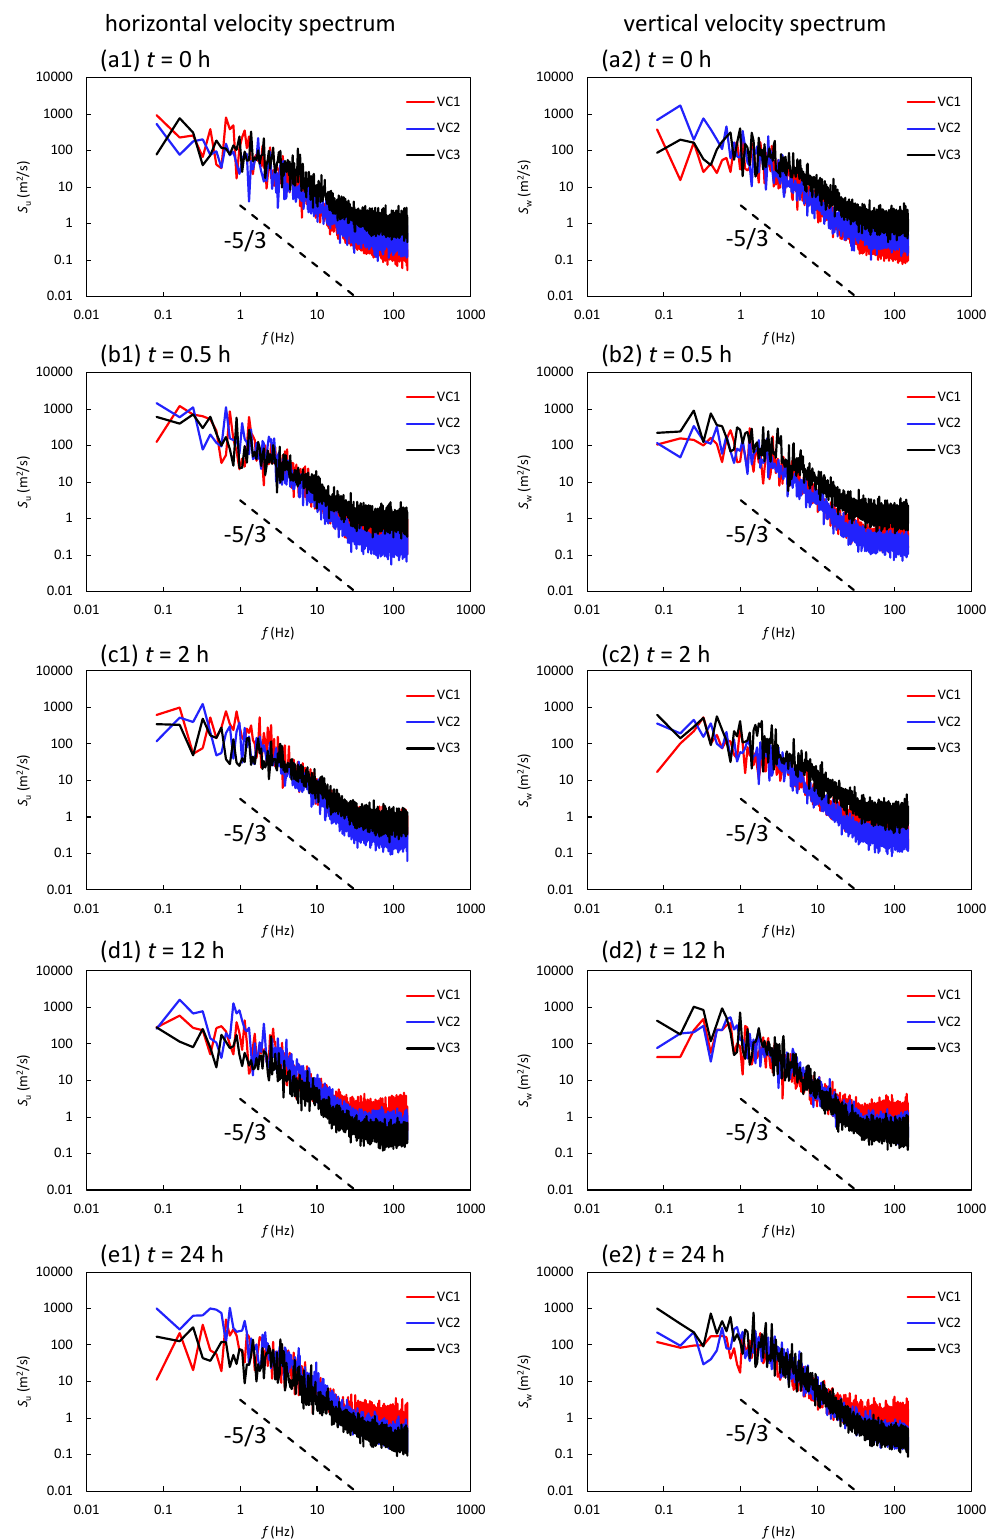
Figure 8. Power spectra of horizontal and vertical velocity fluctuations at vortex core centers of VC1, VC2, and VC3 at X w = 2 D p : ( a1 , a2 ) t = 0 h; ( b1 , b2 ) t = 0.5 h; ( c1 , c2 ) t = 2 h; ( d1 , d2 ) t = 12 h; ( e1 , e2 ) t = 24 h.